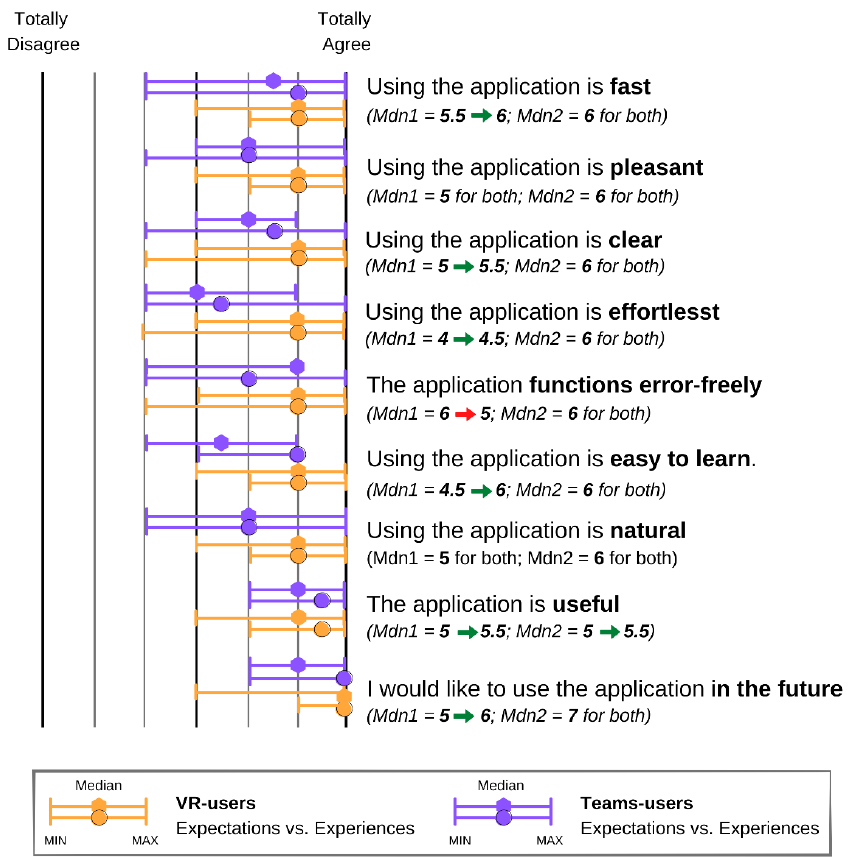
Figure 8. Expectations and experiences with the VR platform.